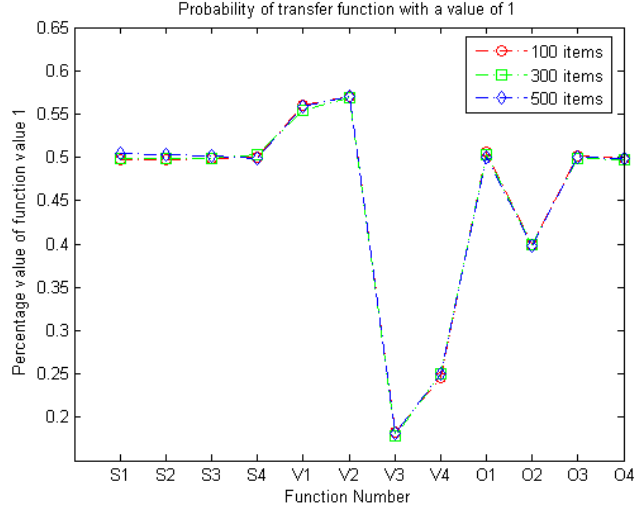
Figure 2. Probability of transfer function with a value of 1.